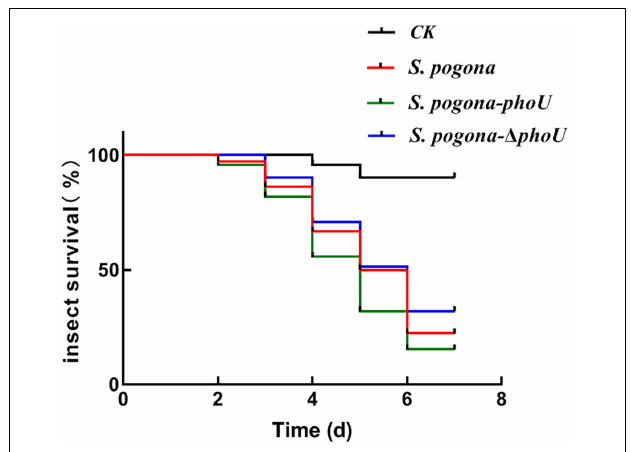
FIGURE 3 | Analysis of insecticidal activity against H. armigera . The fermentation supernatant of Saccharopolyspora pogona - phoU showed stronger insecticidal activity than that of the wild-type and S. pogona - (cid:49) phoU . Feed without fermentation supernatant was used as a control group.